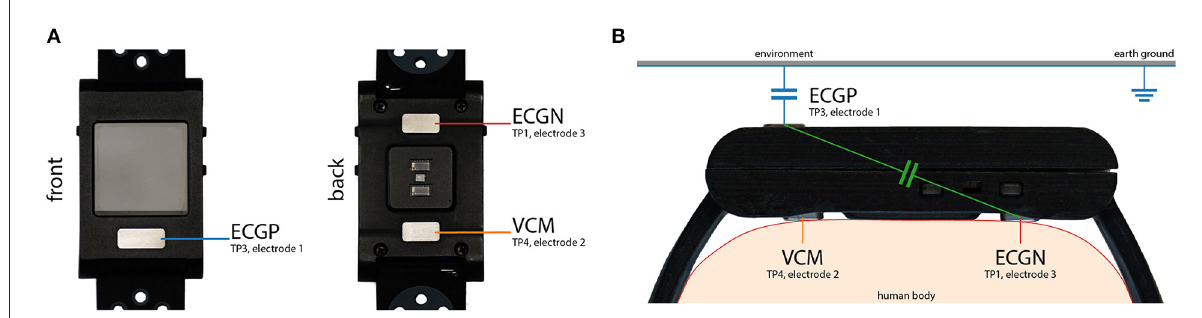
FIGURE4 The ECG sensing device MAXREFDES101# has three electrodes on its casing (A) a positive input (ECGP) at the front, a negative input (ECGN) and a body bias (VCM) at the back. Detection of the artificial landmarks according to the capacitive coupling principle for IBC (B) ECGP and ECGN resemble a parallel plate capacitor (green); ECGN directly couples to the human body (red); ECGP is floating, weakly coupling to the environment to close the circuit (blue); VCM to improve CMRR (orange).